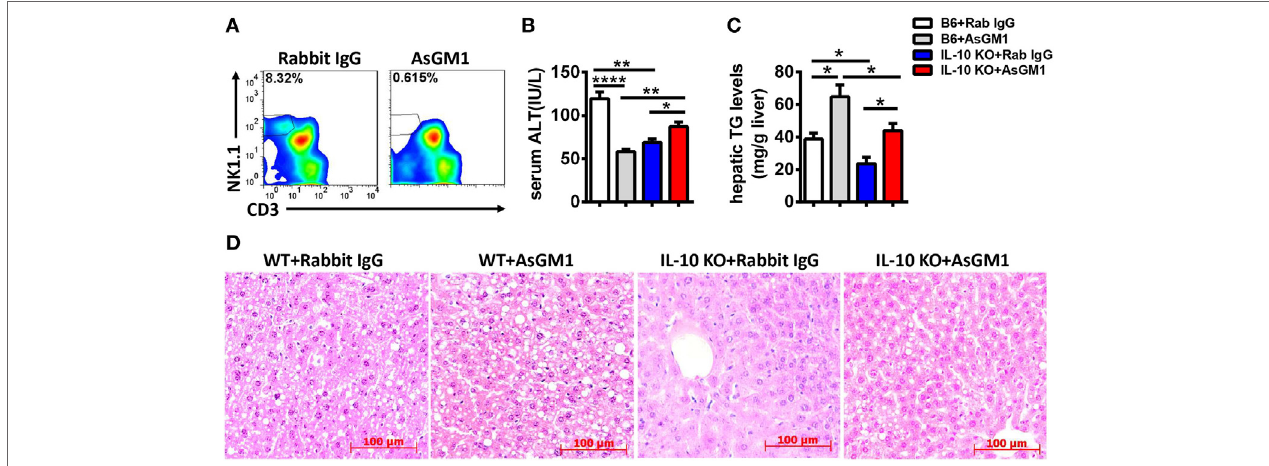
FigUre 11 | Natural killer (NK) cell deficiency promoted alcoholic hepatosteatosis in interleukin-10 (IL-10) KO mice. Ethanol-fed wild-type or IL-10 KO mice were treated with anti-asialo GM1 or control rabbit IgG once every 3 days as described in Section “Materials and Methods” to deplete NK cells. The mice were euthanized 9 h after gavage. (a) Liver mononuclear cells were isolated, and the depletion efficiency was verified by flow cytometry; (B–D) liver injury and steatosis were evaluated based on (B) serum alanine aminotransferase and (c) hepatic triglyceride levels and (D) liver tissue hematoxylin and eosin staining (original magnification, 200 × ). The data are representative of two independent experiments and are shown as the mean ± SEM ( n = 4–5). * P < 0.05; ** P < 0.01; **** P <